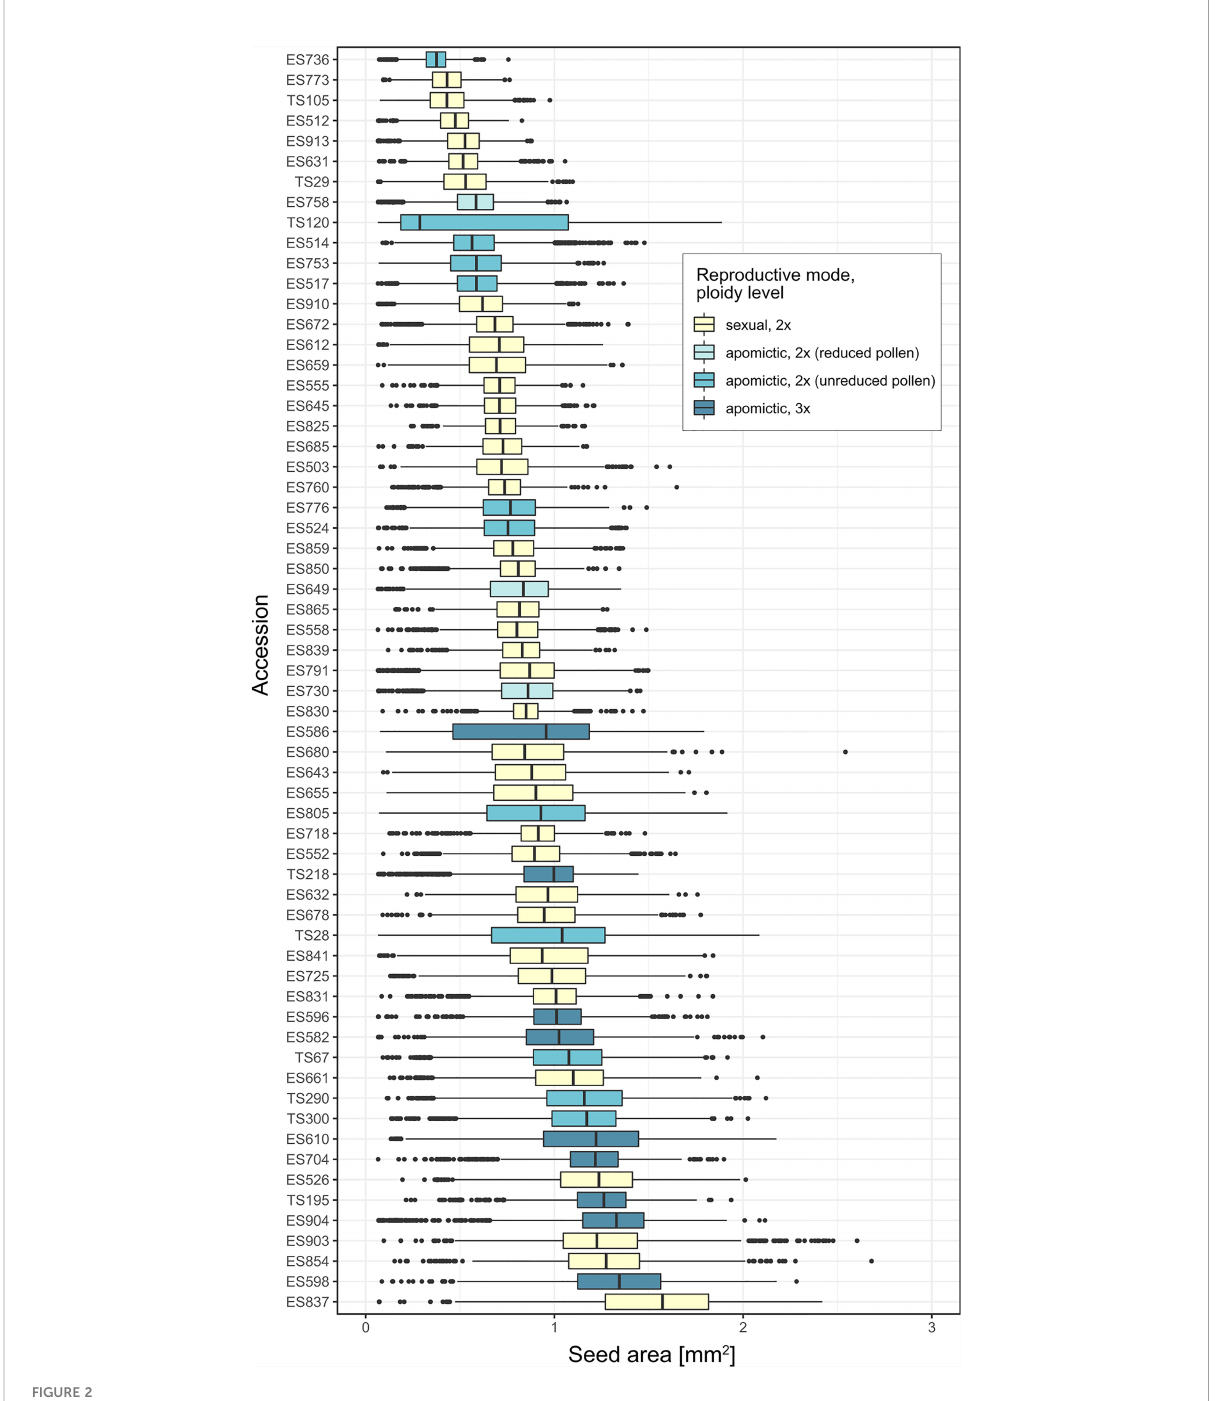
FIGURE 2 Boxplots of projected seed area [mm 2 ] per accession, ordered by mean seed